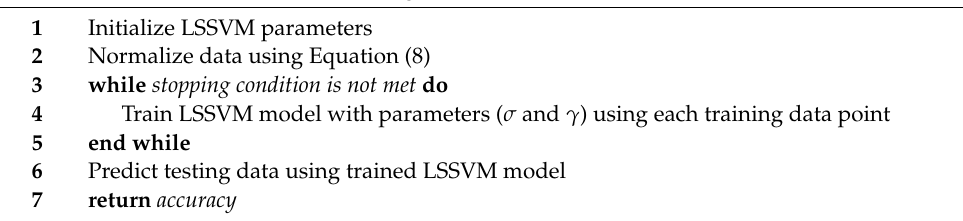
Algorithm 1: Pseudo-code of LSSVM